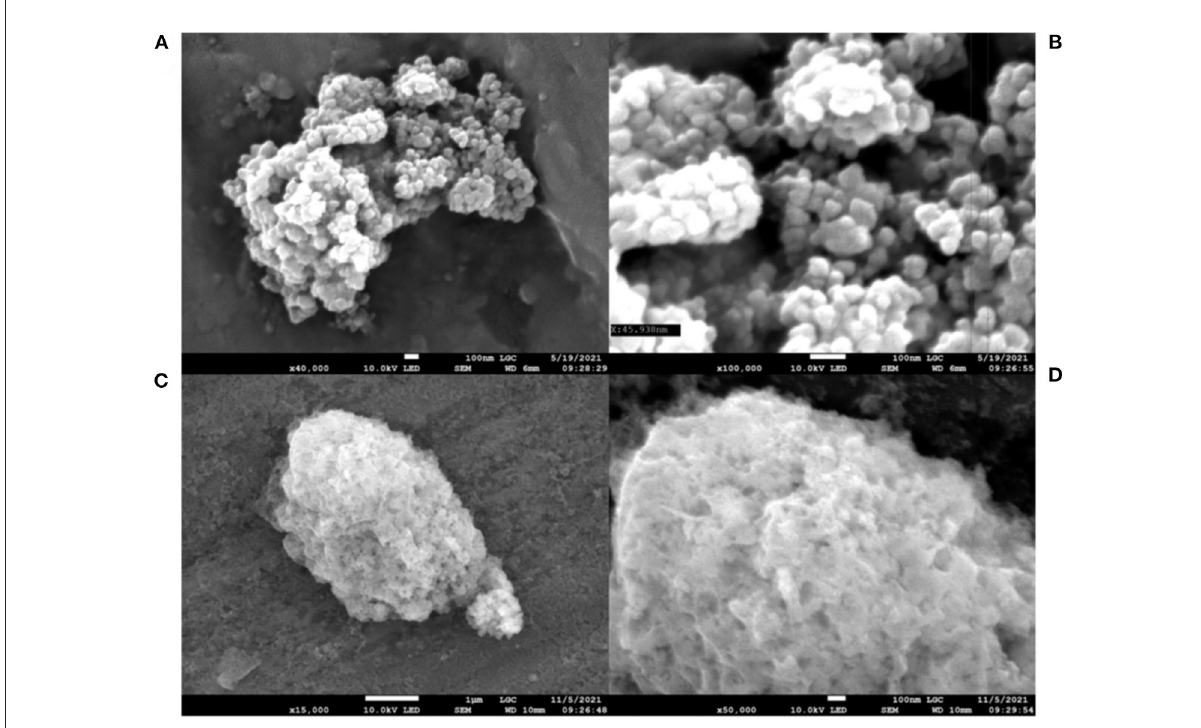
FIGURE8 SEM images of reaction products after 24h of reaction: (A,B) AC mode; (C,D) A-C